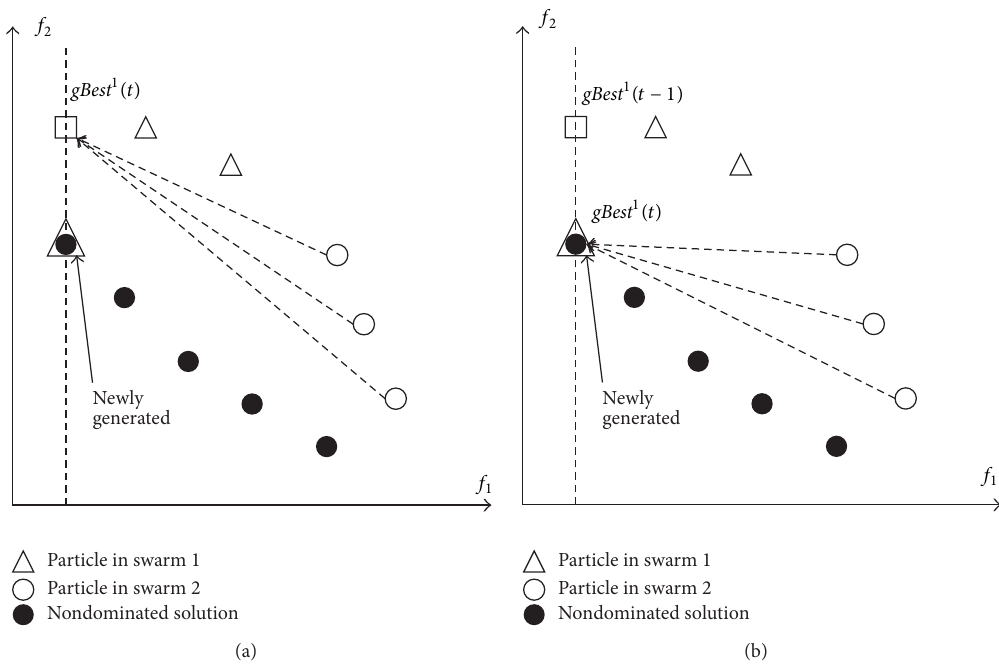
Figure 3: Particles guided by (a) the best solution from the other swarm and (b) a nondominated